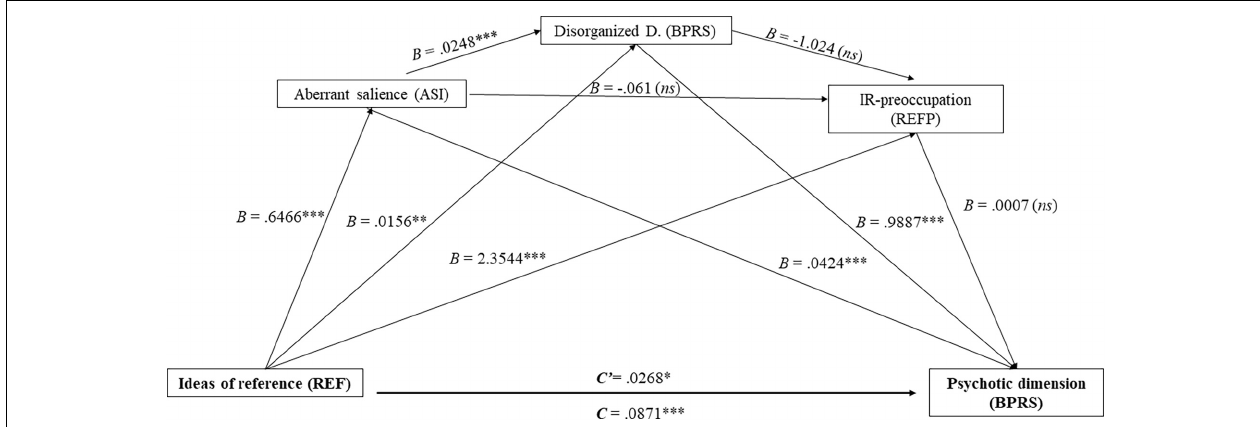
preoccupation about IR were added to the model, the size of the beta coefficient decreased, although still remaining